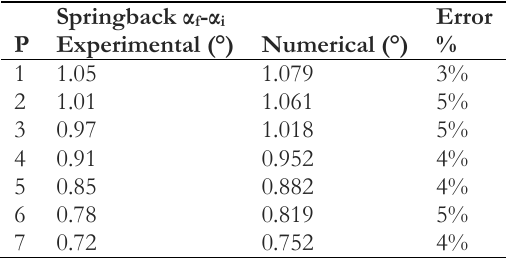
Table 6. Error for thickness 2 mm.